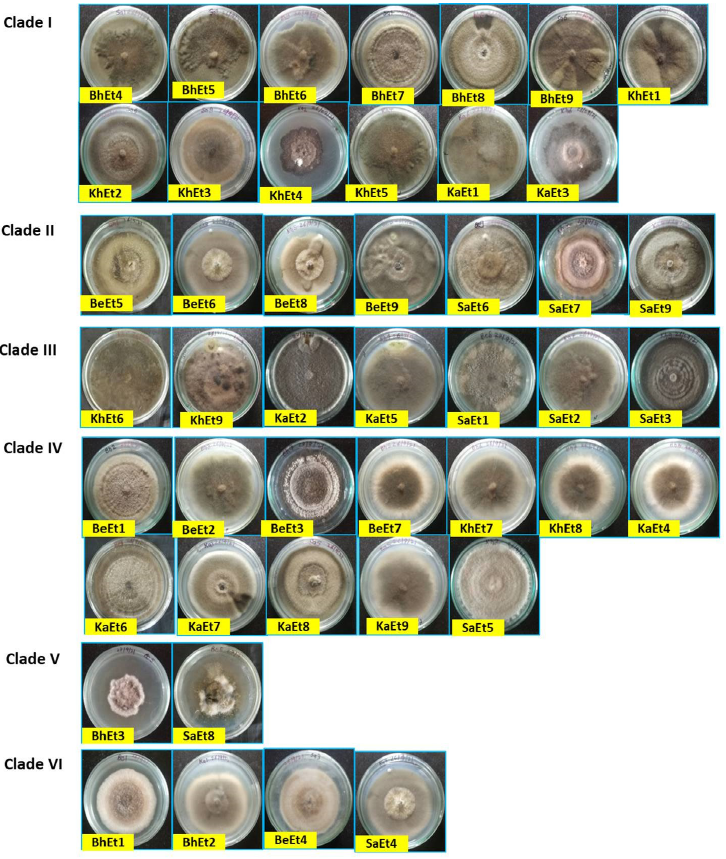
Figure 1. Cultural and morphological variability of different isolates of E. turcicum on PDA (front view) 10 days after inoculation.